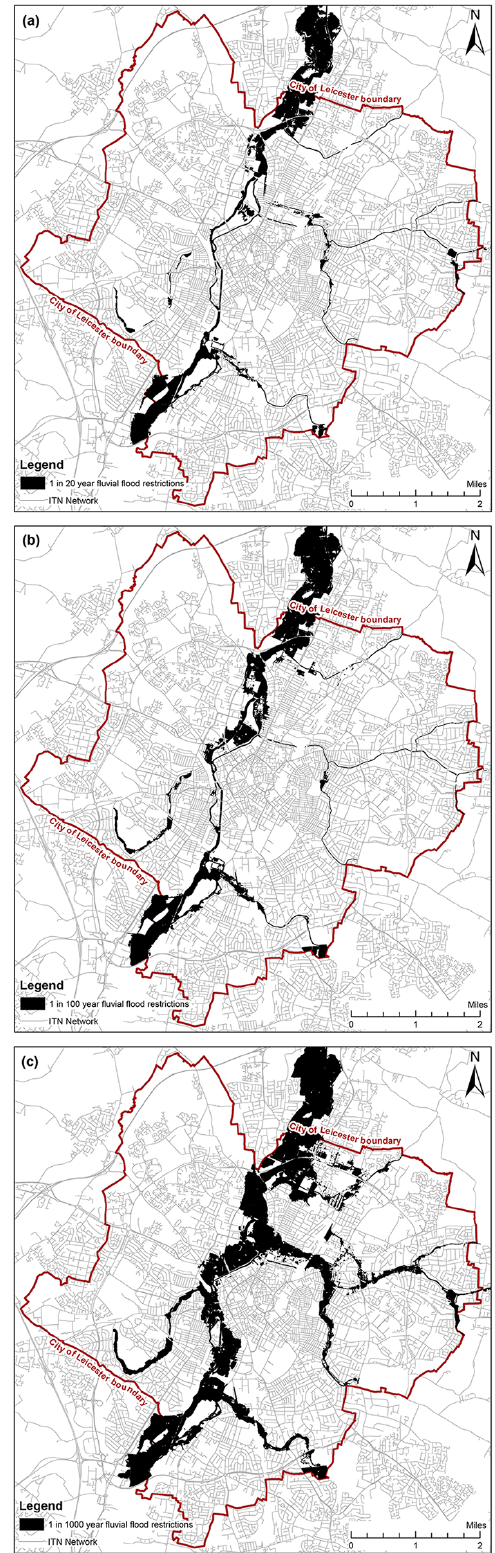
Figure 4. Fluvial flood restrictions under (a) 1 in 20-year, (b) 1 in 100-year and (c) 1 in 1000-year